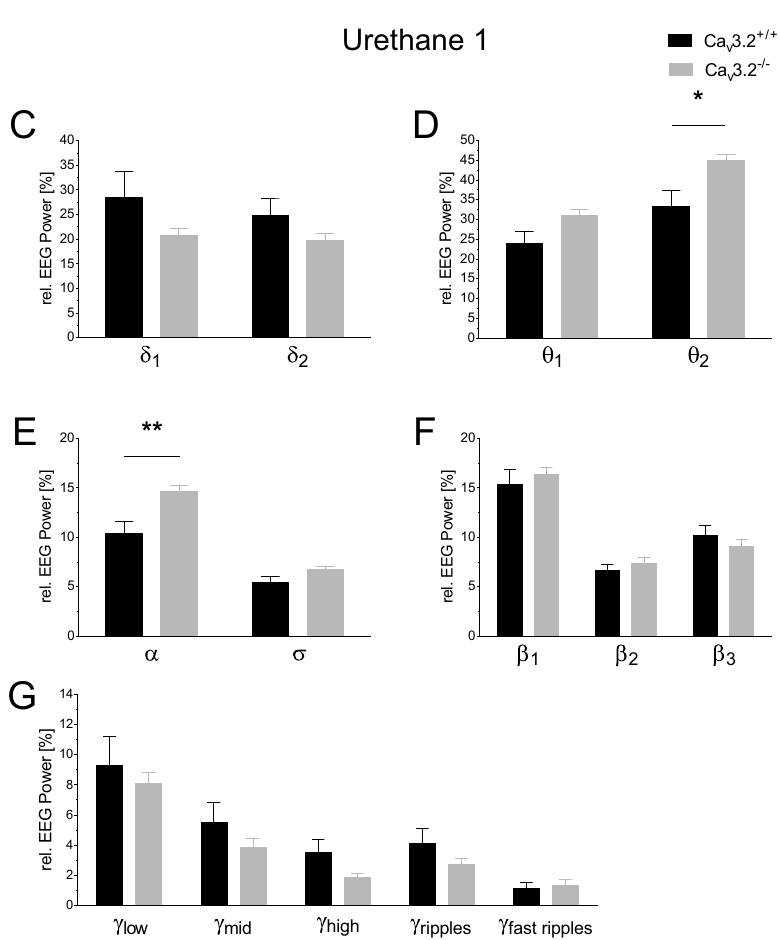
Figure 8. Frequency analysis in Ca v 3.2 +/+ and Ca v 3.2 −/− mice following urethane (800 mg/kg i.p.) injection (U1). ( A ) CA1 EEG traces (30 s) from Ca v 3.2 +/+ and Ca v 3.2 −/− mice. Prior to urethane injection, baseline recordings ( A I , B I ) display characteristic large irregular activity (LIA). Following urethane administration ( A II , B II ), the EEG exhibits prominent theta oscillations in Ca v 3.2 −/− mice ( B II ). Scale: y-axis, 200 μV; x-axis, 3 s. ( C–G ) Relative EEG power (%) for Ca v 3.2 +/+ and Ca v 3.2 −/− mice is displayed for the individual frequency ranges ( A–E ). Urethane which is used to induce atropine sensitive type II theta oscillations, caused a significant increase in θ 2 and α relative EEG power ( D , E